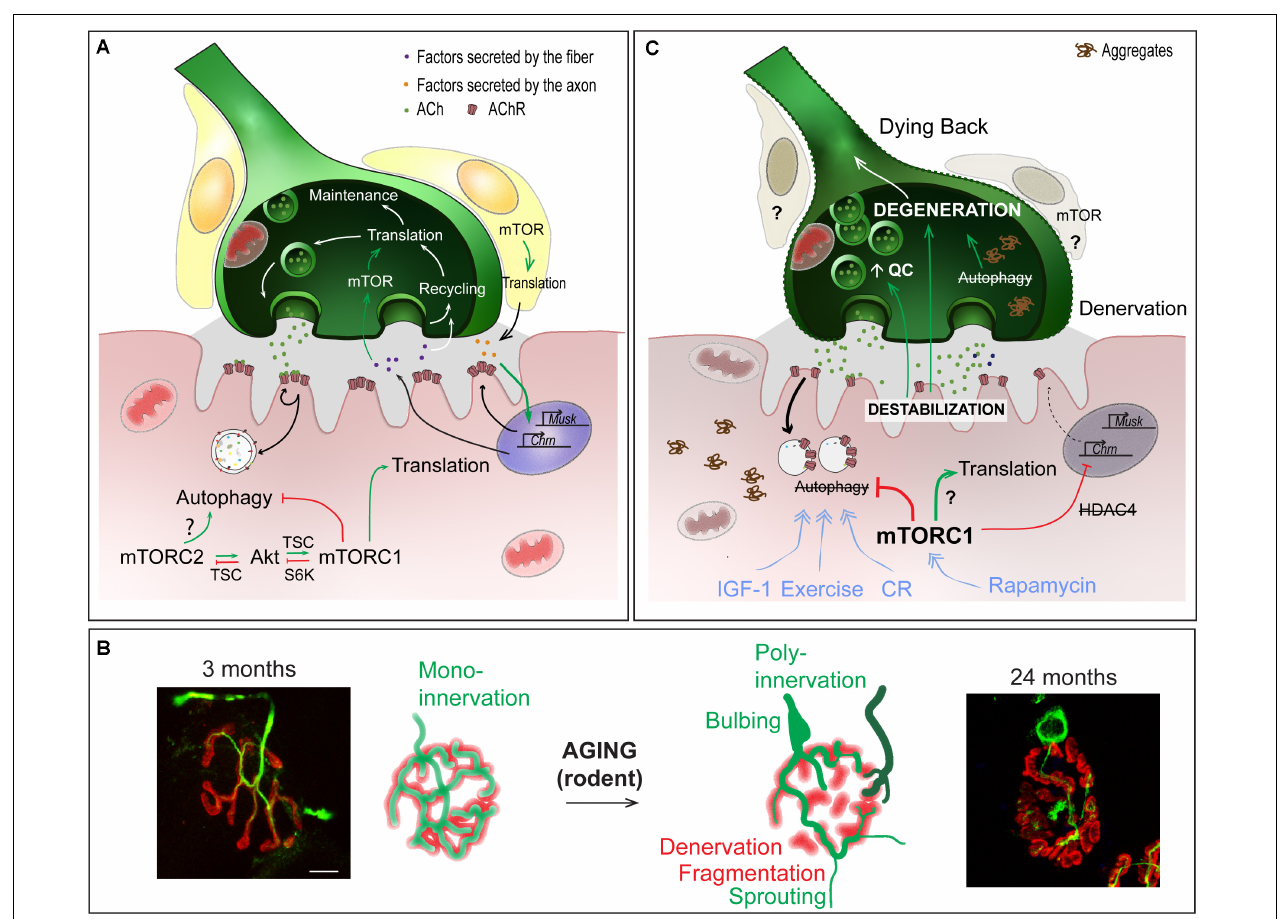
FIGURE 4 | Role of mTOR-dependent processes in NMJ alteration upon aging. (A) Importance of protein synthesis and autophagy in the pre- and post-synaptic compartments of NMJs. (B) Age-dependent changes in NMJ morphology, showing post-synaptic changes ( e.g. fragmentation, denervation) and compensatory changes in the pre-synaptic region ( e.g., sprouting, poly-innervation). Scale bar, 10 µ m. (C) Pathomechanisms involved in NMJ deterioration in aged muscle, and associated with (m)TOR deregulation. Primary destabilization of the post-synaptic compartment likely involves autophagy blockade and defective turnover in synaptic proteins. Changes in neural transmission, including increase in quantal content (QC) may be an attempt to compensate for post-synaptic decline and may in turn further aggravate NMJ deterioration. Decline of the post-synaptic compartment and retrograde feedback from muscle onto motor neuron may lead to the degeneration of the motor axon (dying back process). Exercise, IGF1, rapamycin and caloric restriction (CR) may limit age-related NMJ deterioration by modulating autophagy and/or (m)TOR-associated complexes. Red lines indicate inhibition; Green arrows represent activation; blue arrows show the beneficial effect of